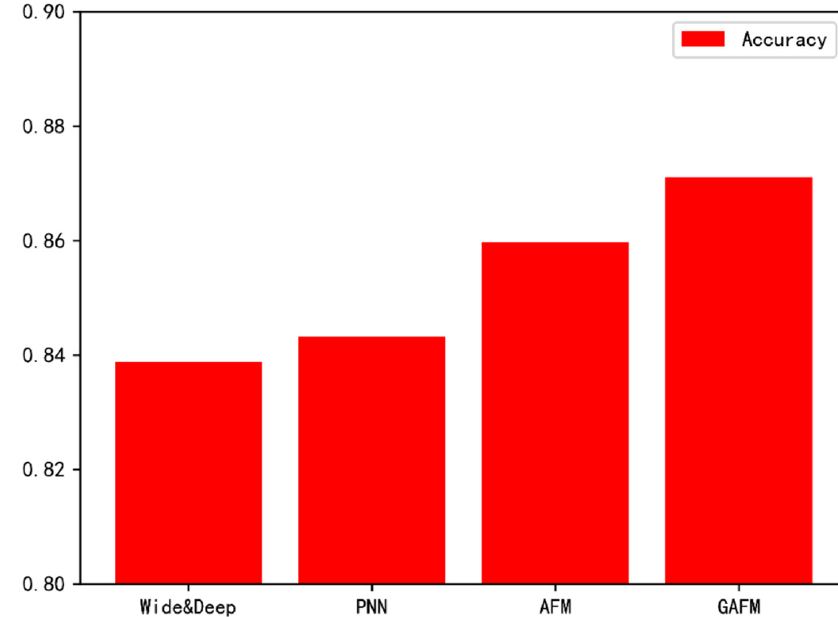
Figure 20. The accuracy of each model is compared.